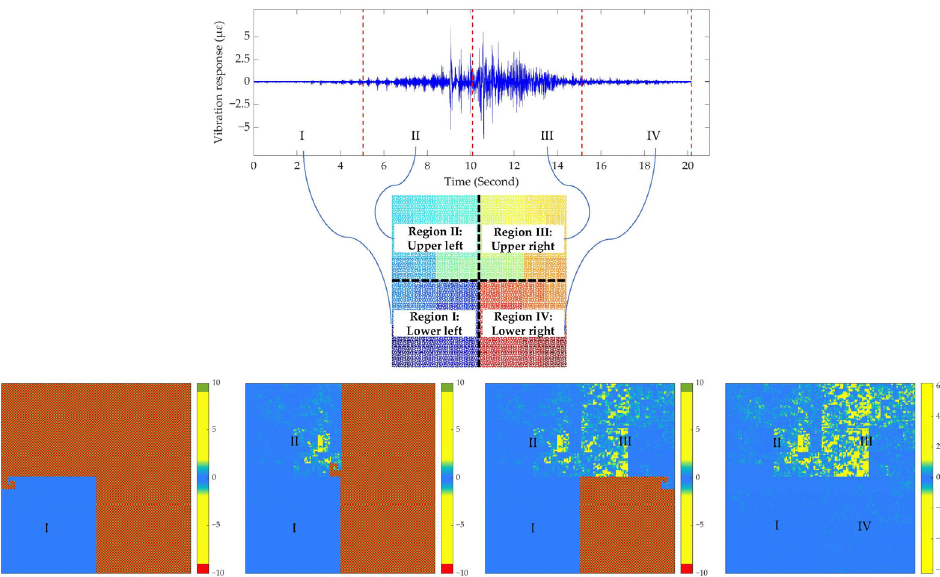
Figure 7. Pseudo-Hilbert scan results of a typical subway track bed vibration signal. Table 4. Performance evaluation of the CAE network from four indicators in the case of the test dataset. Indicator Accuracy